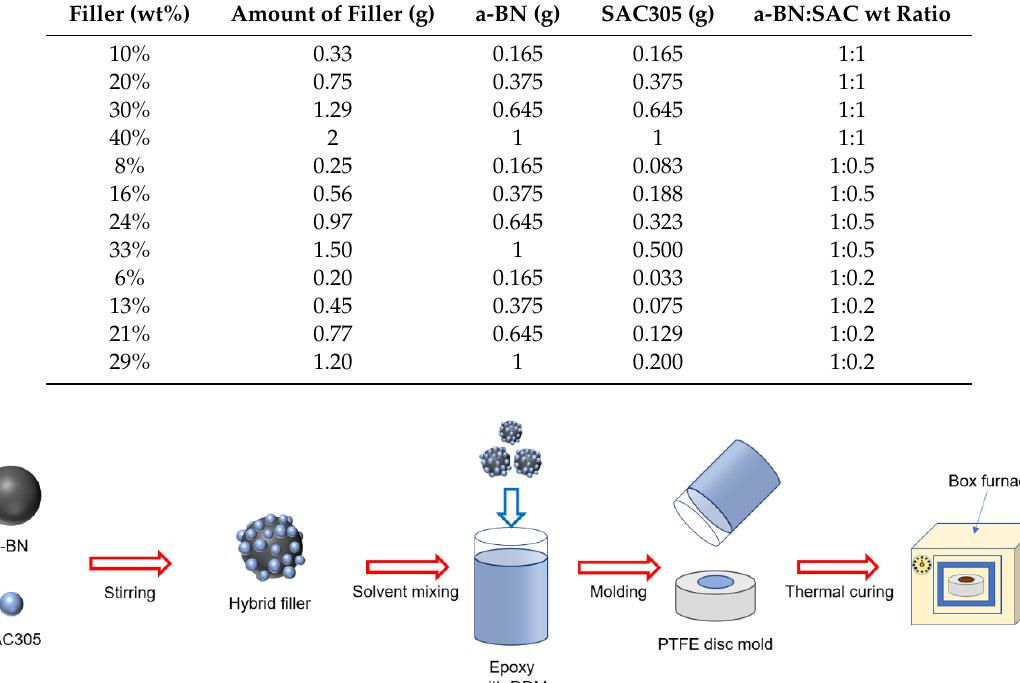
Table 1. Experimental condition for preparation of composites with various ratios of the hybrid fillers. Filler (wt%) Amount of Filler (g) a-BN (g) SAC305 (g) a-BN:SAC wt Ratio 10% 0.33 0.165 0.165 1:1 20% 0.75 0.375 0.375 1:1 30% 1.29 0.645 0.645 1:1 40% 2 1 1 1:1 8% 0.25 0.165 0.083 1:0.5 16% 0.56 0.375 0.188 1:0.5 24% 0.97 0.645 0.323 1:0.5 33% 1.50 1 0.500 1:0.5 6% 0.20 0.165 0.033 1:0.2 13% 0.45 0.375 0.075 1:0.2 21% 0.77 0.645 1:0.2